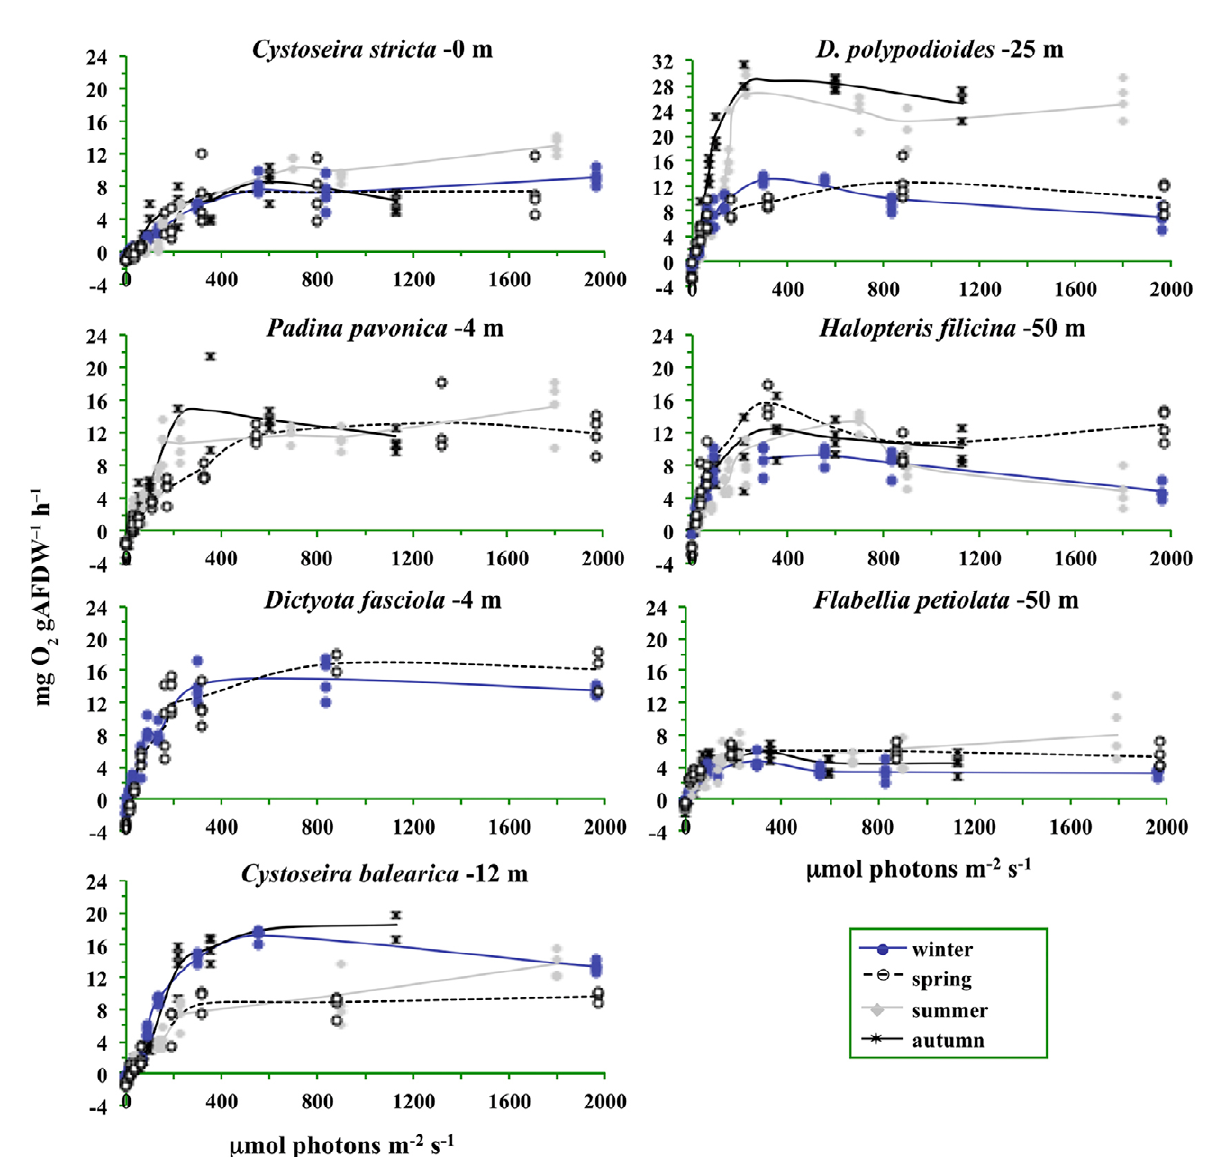
Fig. 3. – Photosynthesis/irradiance curves for the seven species in different seasons. Note that the Y scale for Dictyopteris polypodioides is